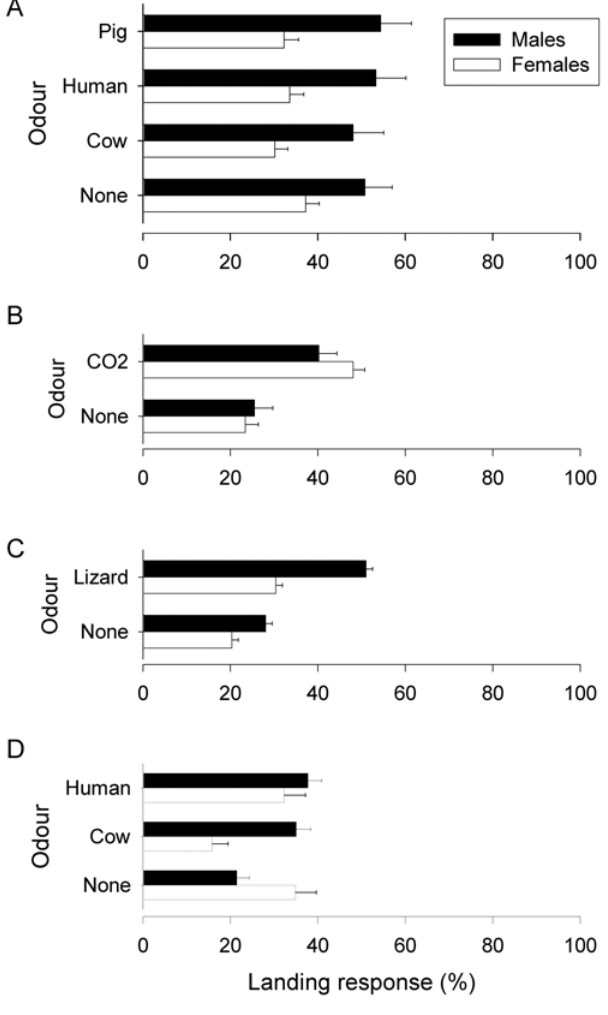
Figure 1. Landing response of G.f.fuscipes on a large (1 6 1 m) E-target baited with either (A) mammalian host odours or (B) carbon dioxide dispensed outside a tent, or on a small (0.5 m high 6 1 m wide) E-target baited with (C) lizard or (D) mamma- lian host odours. The landing response is the number of tsetse caught landing on the target expressed as a percentage of the total (landing + circling) catch.